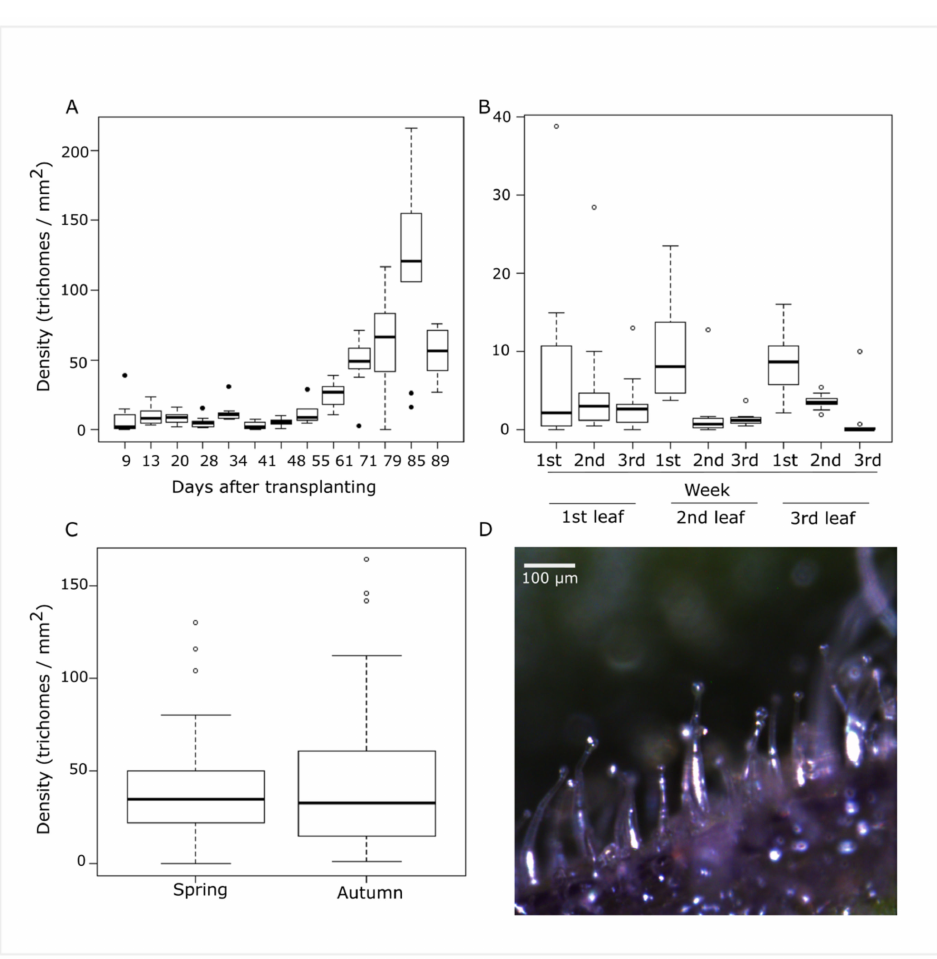
Figure 1. Effect of plant age ( A ), leaf age ( B ) and growing season ( C ) on type IV trichome density. Photography of trichomes type IV ( D